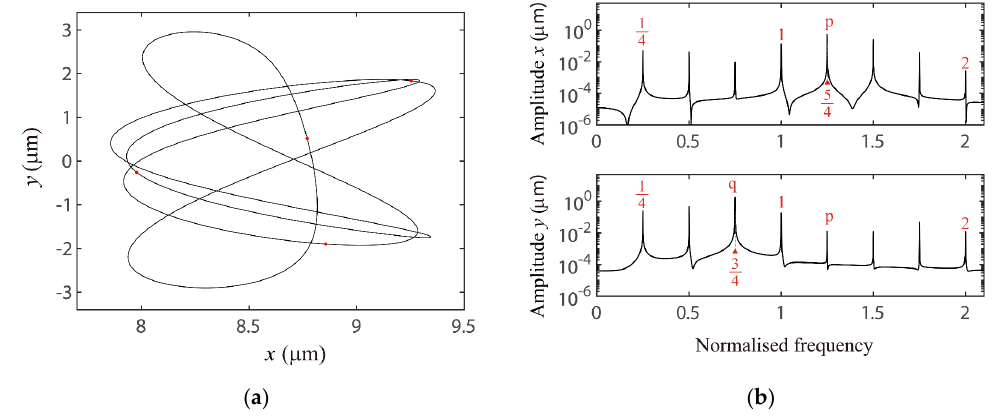
Figure 23. For δ 0 = 4.0 μ m, response characteristics of the VC period-4 motion when Ω = 180 rad/s, ( a ) orbit (black line) and its Poincare mapping (red dots), ( b ) frequency spectrum.